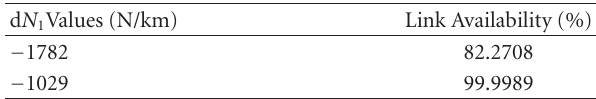
Table 3: Link availability due to global and experimental dN 1